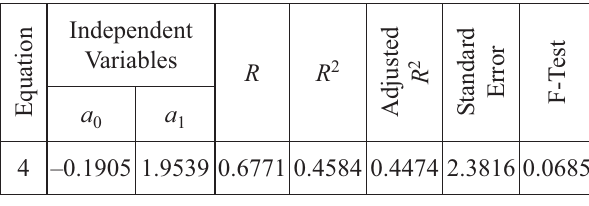
Table 3 . Regression Result of Transaction Prices Versus Forced Sale Values